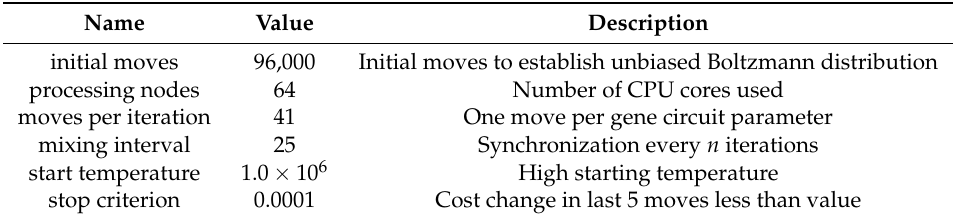
Table 2. Parameter settings for parallel simulated